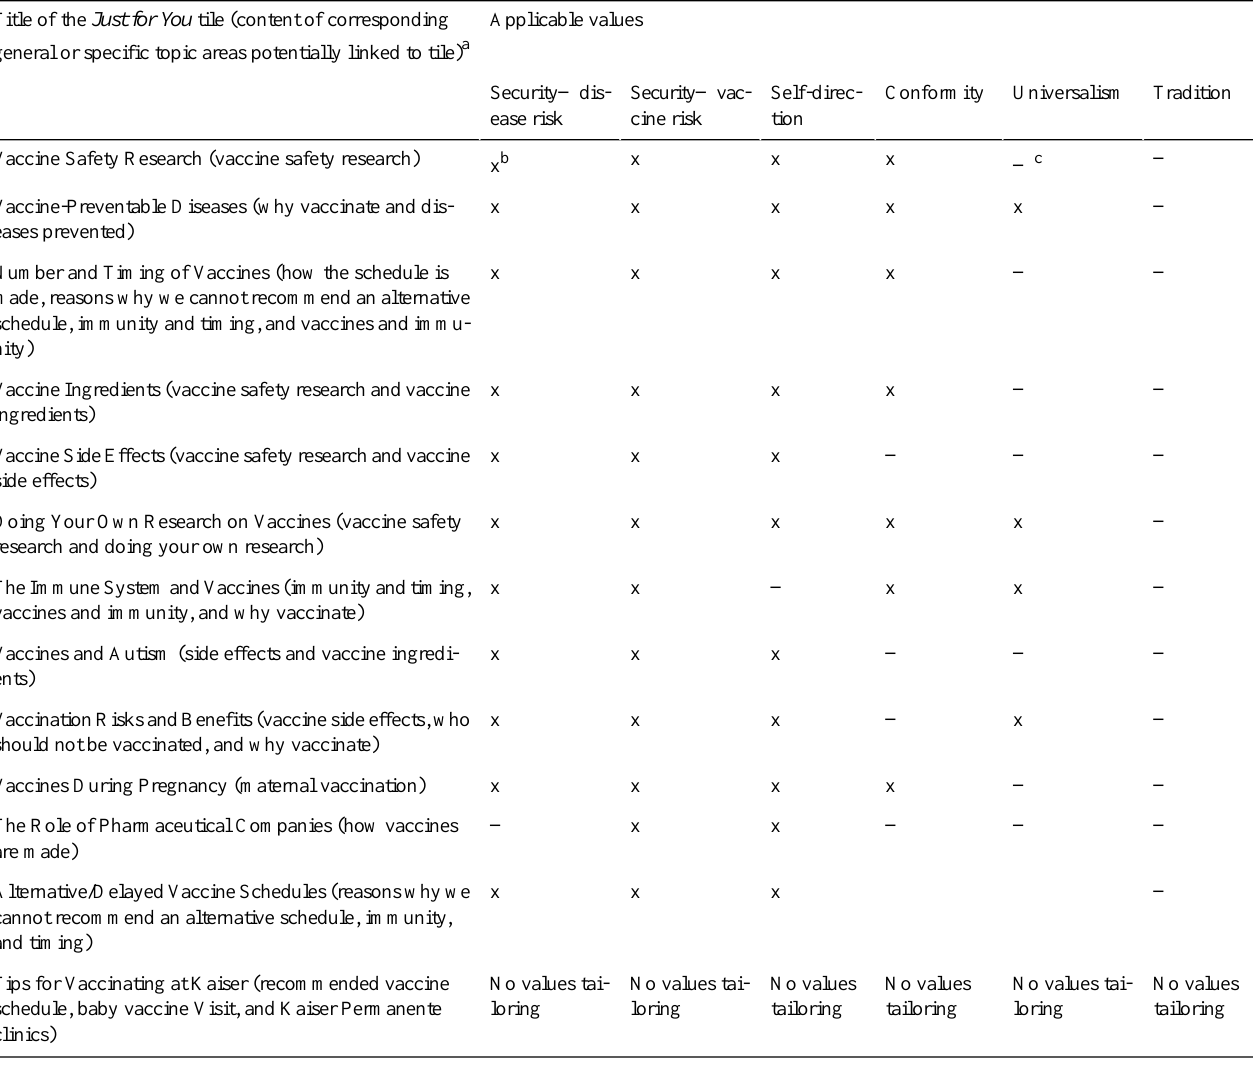
Applicable valuesTitle of the Just for You tile (content of corresponding